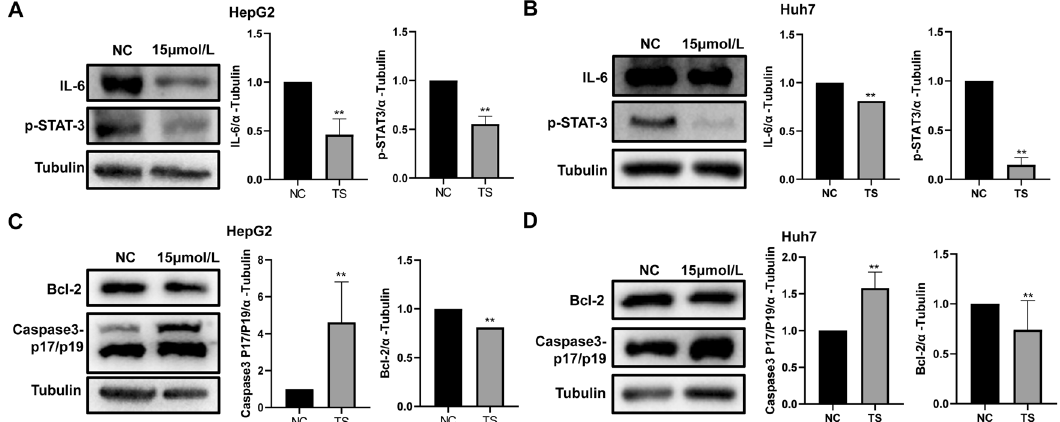
Fig. 5 TS affected the expression of apoptosis related proteins and IL-6/STAT3 pathway related proteins in HepG2 and Huh7 cells. The expression of IL-6 and p-STAT-3 after treatment by TS (15 μ mol/l) in HepG2 cells ( A ) and Huh7 cells ( B ).The expression of apoptosis related proteins (Bcl-2 and cleaved Caspase-3) after treatment by TS in HepG2 cells ( C ) and Huh7 cells ( D ). Results were obtained from experiments carried out in triplicate from at least three independent experiments. Data are presented as the mean ± SD ( n = 5). * p < 0.05 vs. the Control group; ** p < 0.01 vs. the Control group; *** p < 0.001 vs. the Control group.